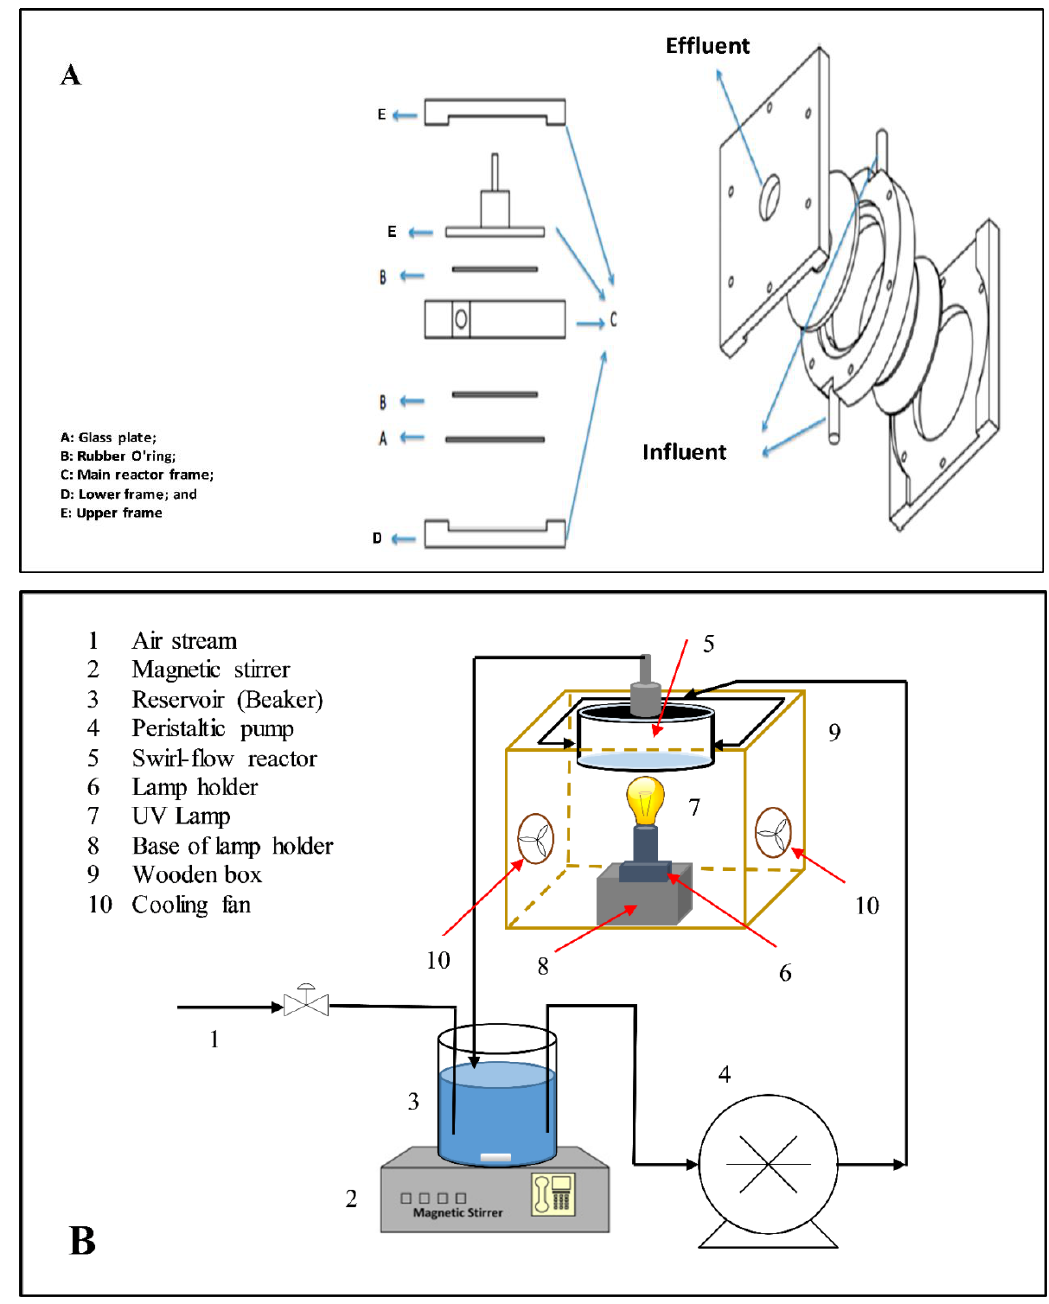
Figure 2. ( A ) The design layout of the swirl flow photoreactor and ( B ) A schematic representation of the experimental setup.